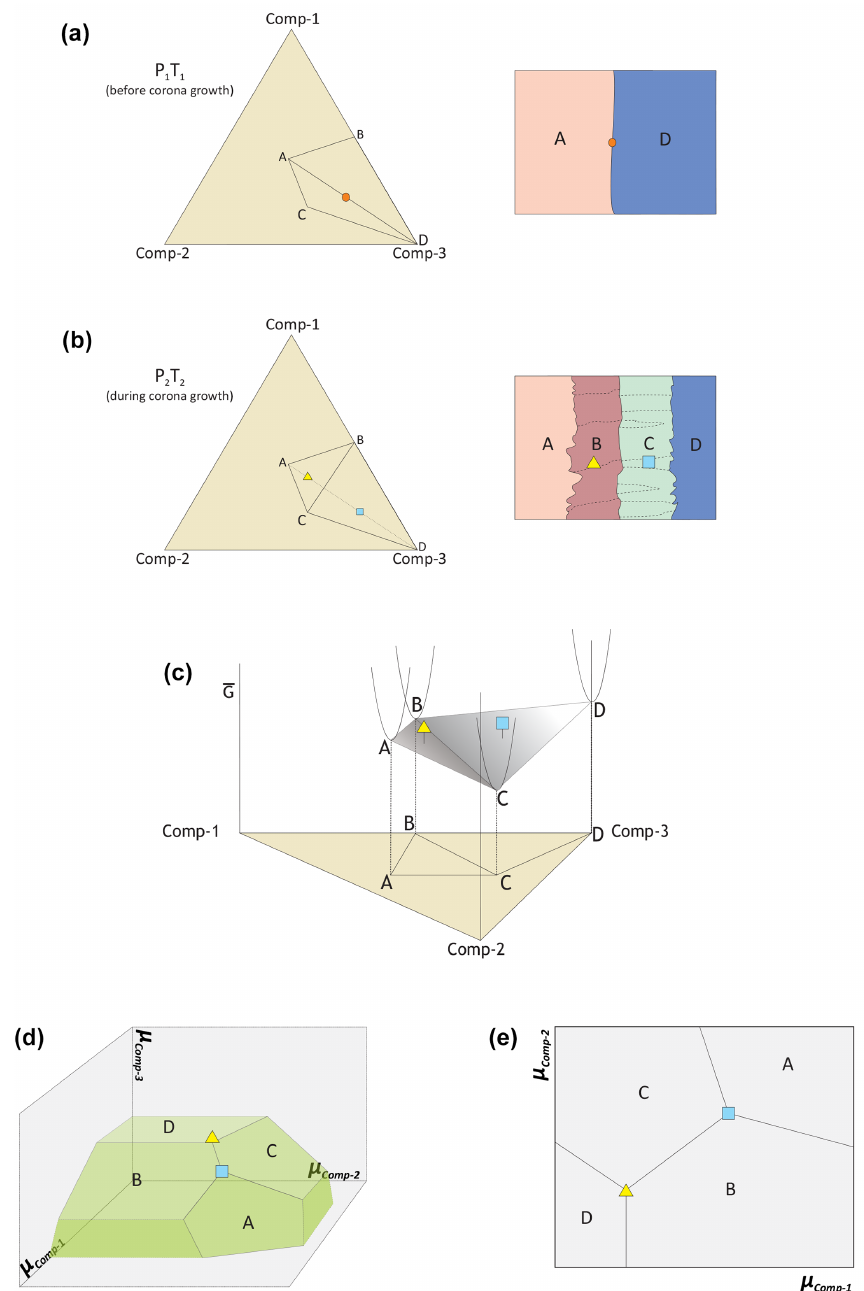
Figure 1. Chemographic relationships and chemical potential saturation surfaces for local transient equilibria at corona boundaries during incipient stages of single-stage, steady-state diffusion-controlled corona growth (after Joesten, 1977). (a) Original phases (A and D) initially at equilibrium under P 1 and T 1 , with bulk composition indicated by the circle. (b) Under new P and T conditions ( P 2 , T 2 ) , reaction progress becomes diffusion-controlled. The corona domain is partitioned into a continuum of compositional subdomains, or incipient effective bulk compositions (triangle, square), each with unique chemical potentials, in which local equilibrium is attained. (c) Ternary G – X surface, in which local equilibria are separated by chemical potential differences. (d) The chemical potential saturation surface for each of the local phase assemblages. (e) Projection of the saturation surface on the µ comp1 – µ comp2 plane. Chemical potential gradients between local equilibria drive the diffusion of components from one compositional domain to another until chemical potentials are equalized and equilibrium is attained.